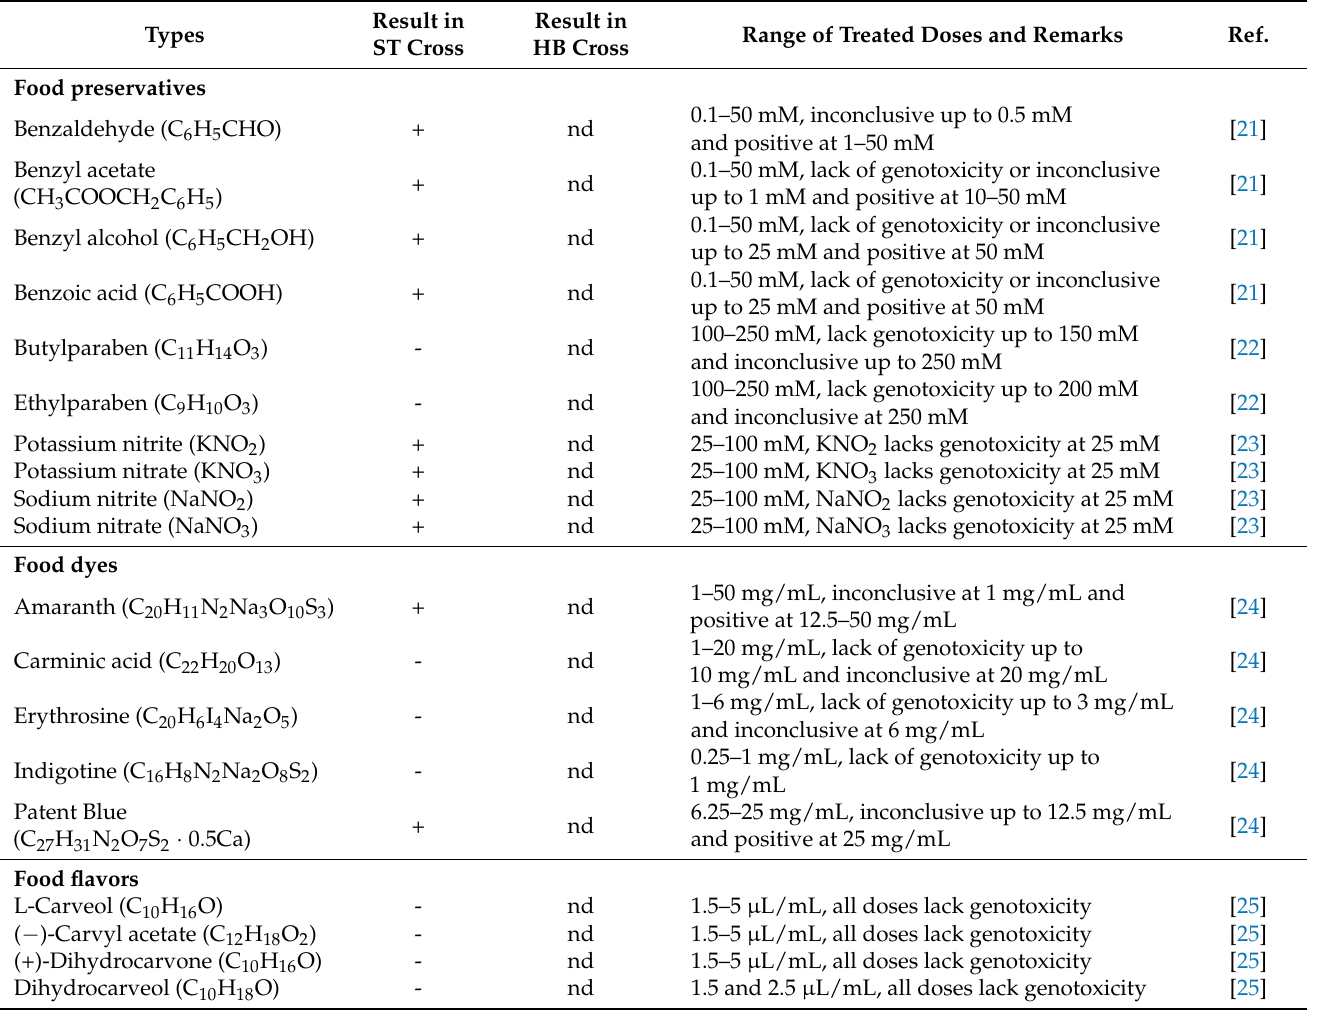
Table 1. Applications of SMART for testing food preservatives, food dyes, synthetic flavors and aroma, plant/herbal extracts, and